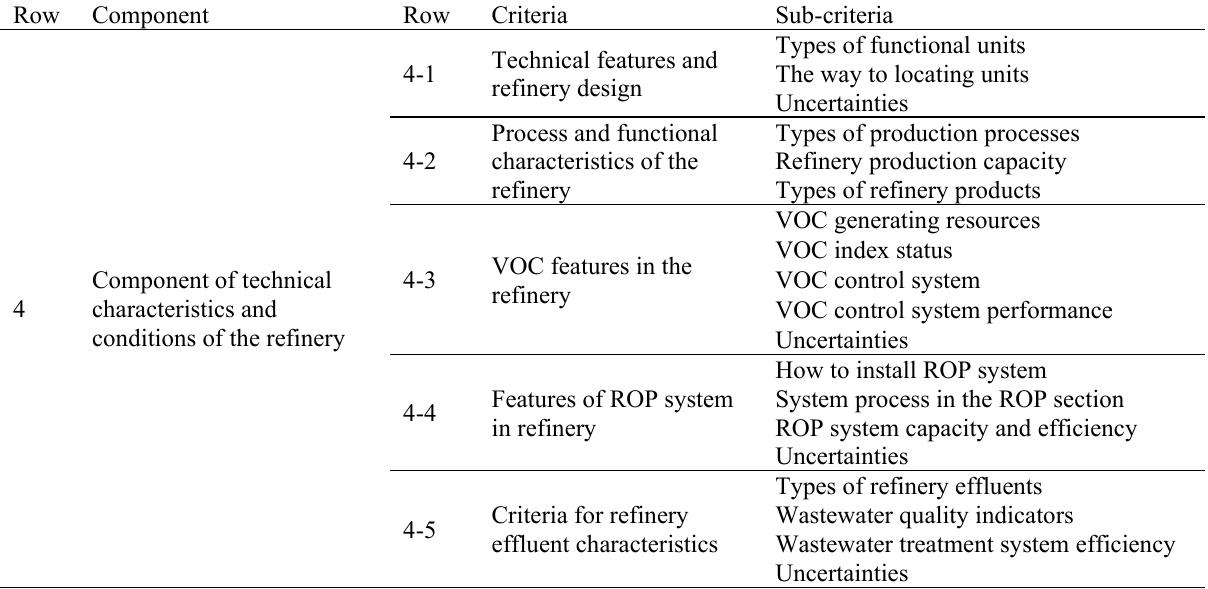
Table 4. Strategic components and criteria for component of technical characteristics and conditions of refinery Row Component Row